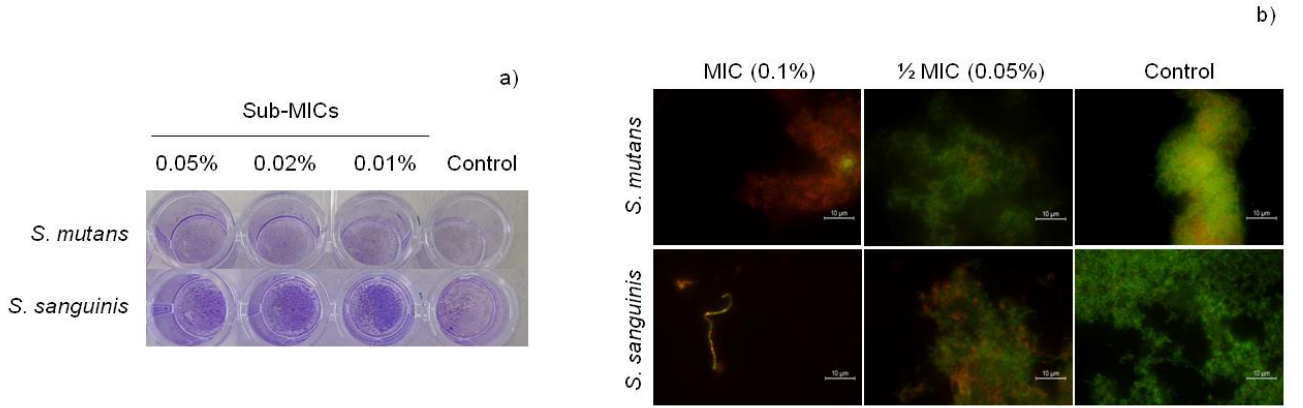
Figure 2. Biofilm remaining after treatment of CAR against S. mutans and S. sanguinis by violet crystal stain assay ( a ); Live/Dead staining of biofilm cells after treatment with CAR ( b ).